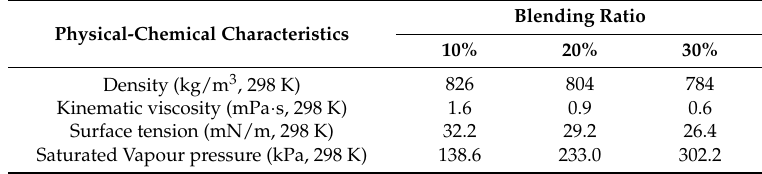
Table 2. Physical-chemical characteristics of and DME/diesel blended fuel with different blending